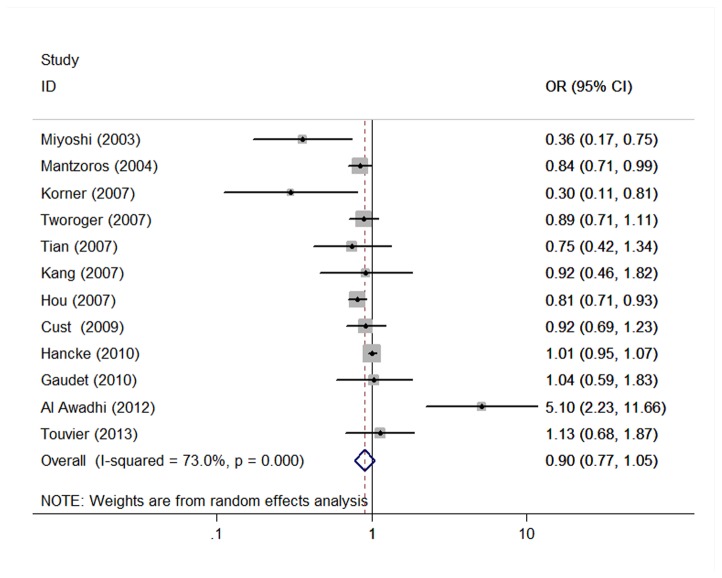
The effect of adiponectin on breast cancer (OR).